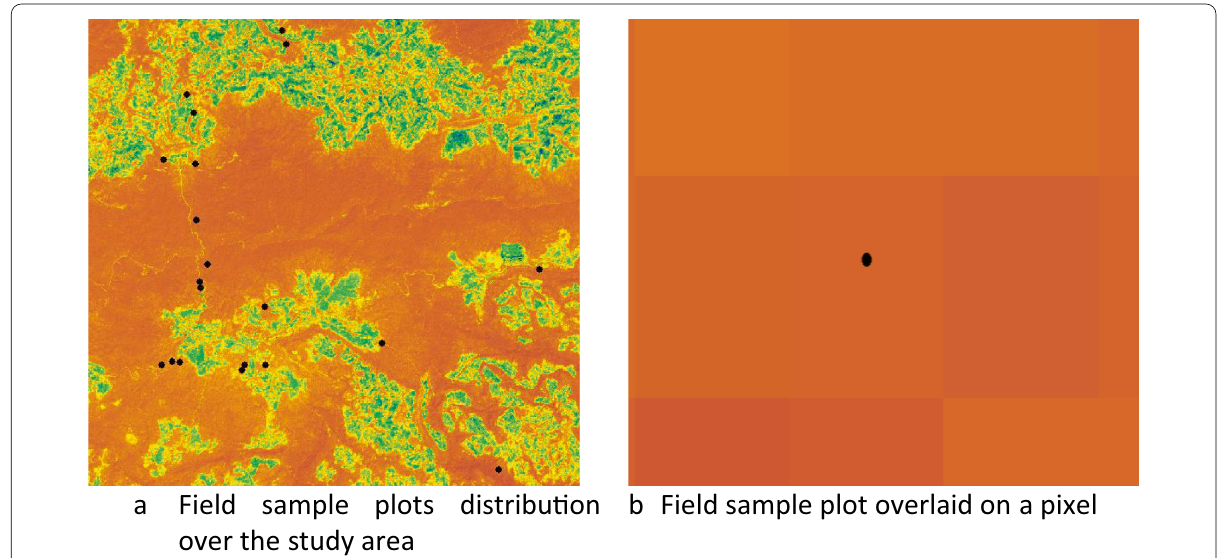
Field sample plots distribu(cid:31)on b Field sample plot overlaid on a pixel over the study area Fig. 7 Pixel values extraction by overlaying field samples plots on Sentinel-2 image pixels in ArcGIS platform